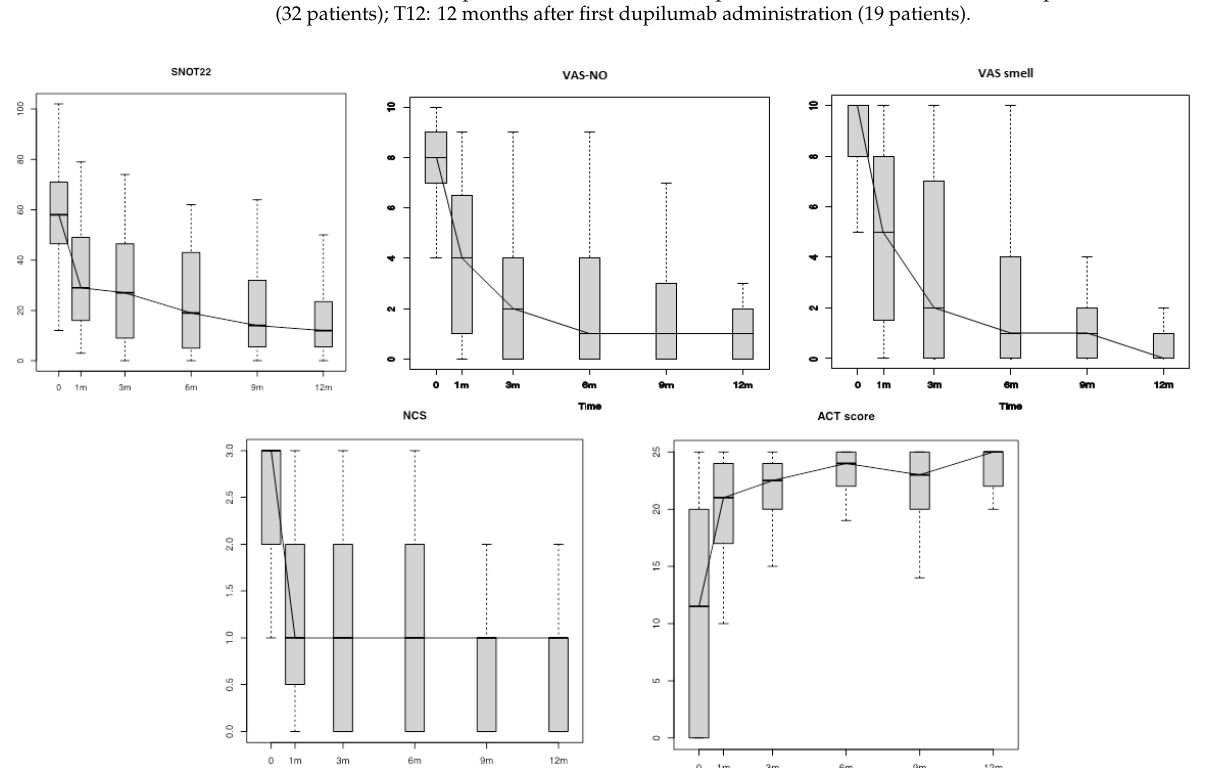
Table 2. Changes in the main clinical outcomes during the study period.